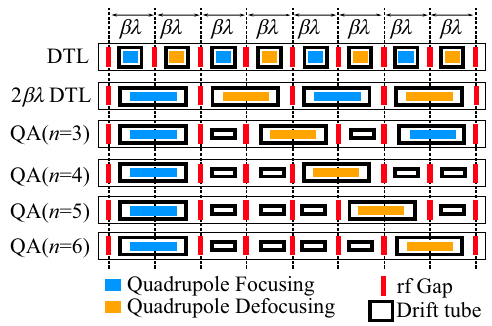
FIG. 2. A schematic illustration of various QA-DTL design options compared to classic DTL design. A long drift tube is placed every n βλ